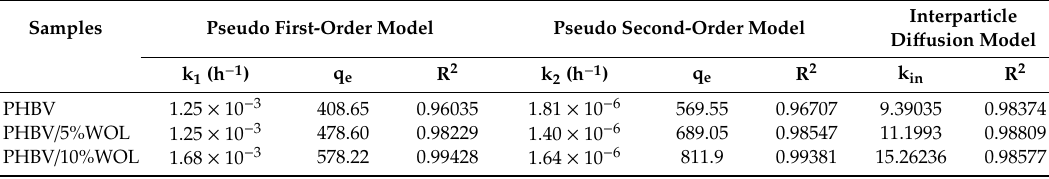
Table 3. Kinetics studies of water uptake to PHBV-S, PHBV / 5%WOL-S and PHBV / 10%WOL-S.